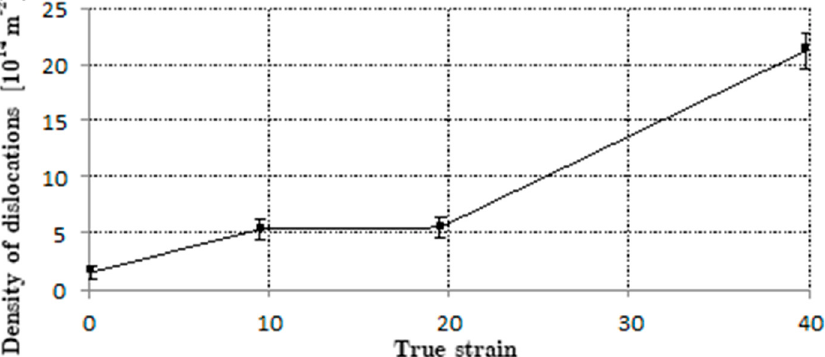
Figure 15. Evolution of the density of dislocations with strain.